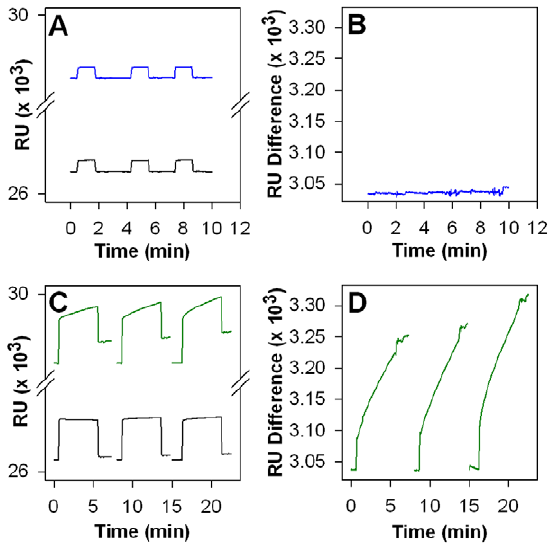
Figure 7. SPR analysis of cisplatin and tannic acid binding immobilized CMG2. A ) SPR sensorgram using a streptavidin- modified carboxydextran gold sensorchip where biotinylated CMG2 was immobilized in channel 2 (blue trace) and biotin-PEG was immobilized in channel 1 (black trace) as a control. A solution of 500 m M cisplatin in HBST was flowed over the sensor surface. Three independent injections are recorded. B ) A difference sensorgram is shown based on the data in Figure 7A. C ) SPR sensorgram where biotinylated CMG2 was immobilized in channel 2 (green trace) and biotin-PEG was immobilized in channel 1 (black trace) as a control. A solution of 1 m M tannic acid in HBST was flowed over the sensor surface. Three independent injections are shown. D ) A difference sensorgram is shown based on the data in Figure 7C.